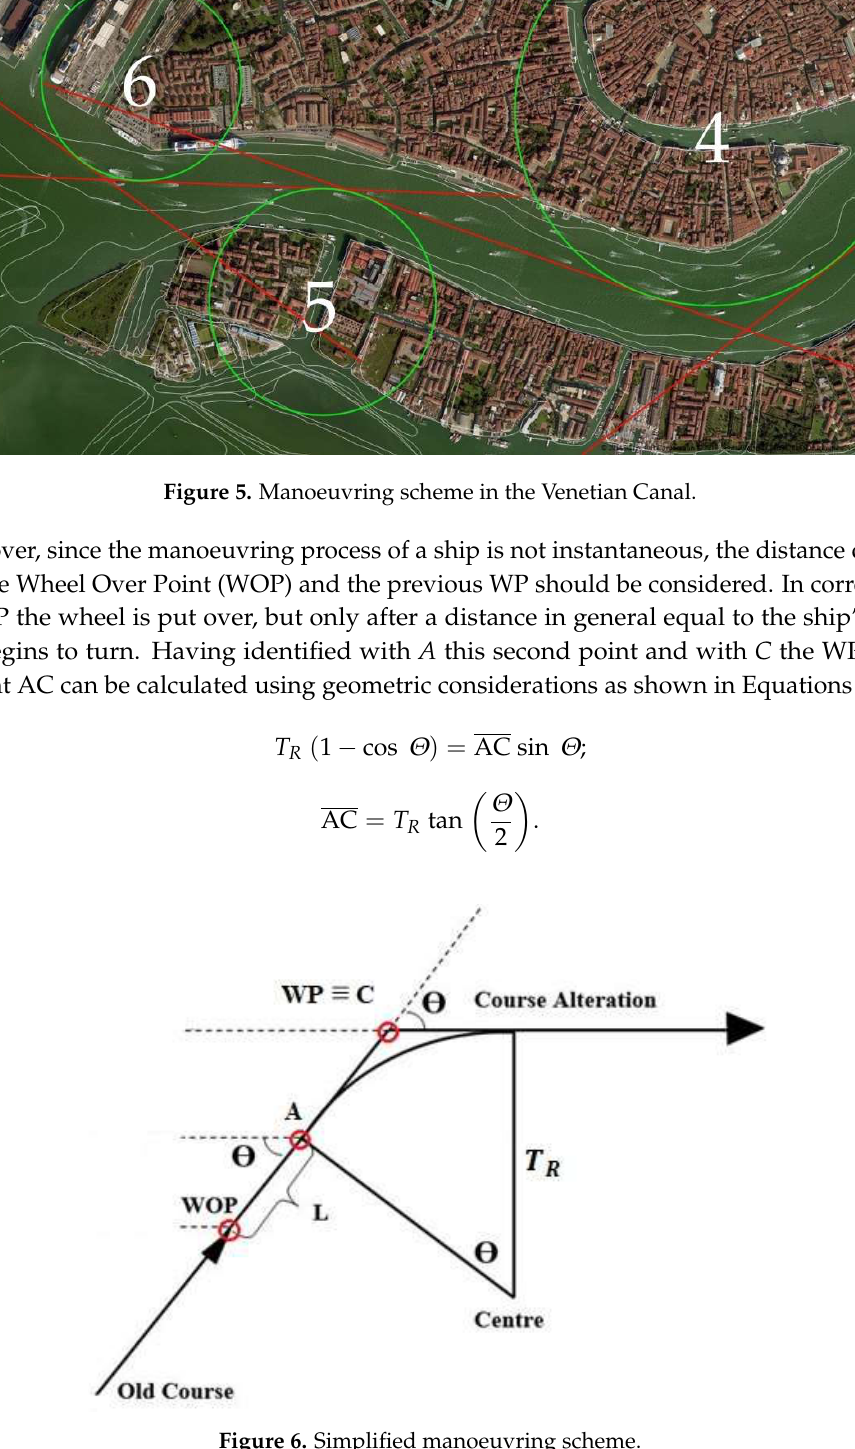
Figure 6. Simplified manoeuvring scheme.